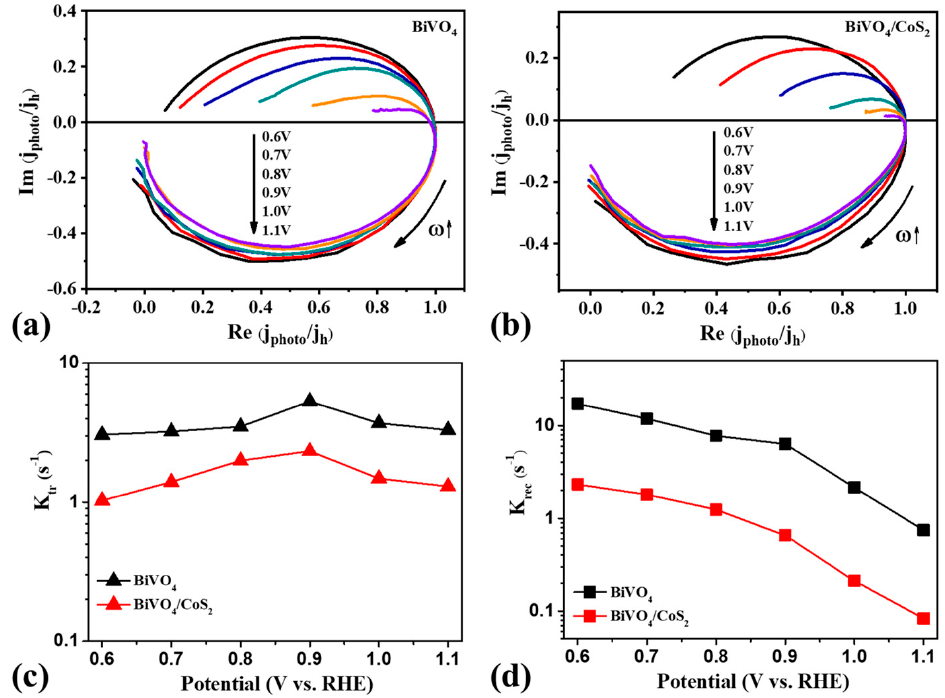
Figure 6. ( a ) IMPS spectra of BiVO 4 . ( b ) IMPS spectra of BiVO 4 /CoS 2 . ( c ) Derived charge transfer rate constant. ( d ) Recombination rate constant for BiVO 4 and BiVO 4 /CoS 2 .